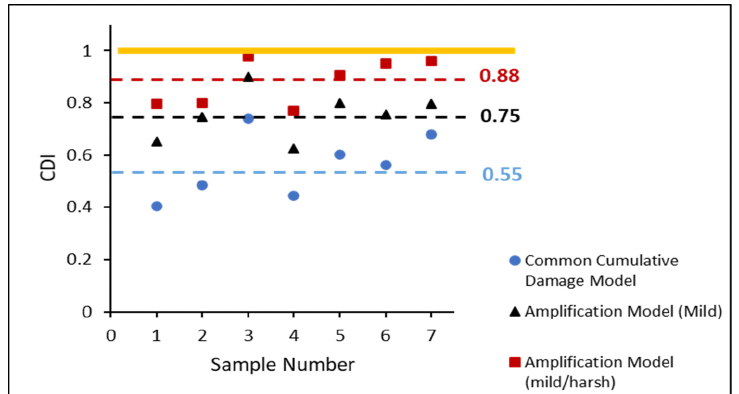
Figure 14. CDI of each totally failed non-aged SAC305 individual solder joint in varying stress am- plitude test.